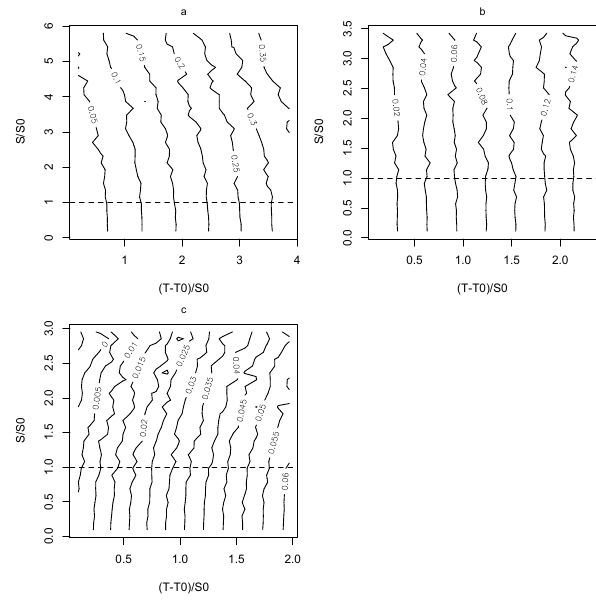
similar to the overall patterns observed with the van’t Hoff in the average (Fig. 6c).